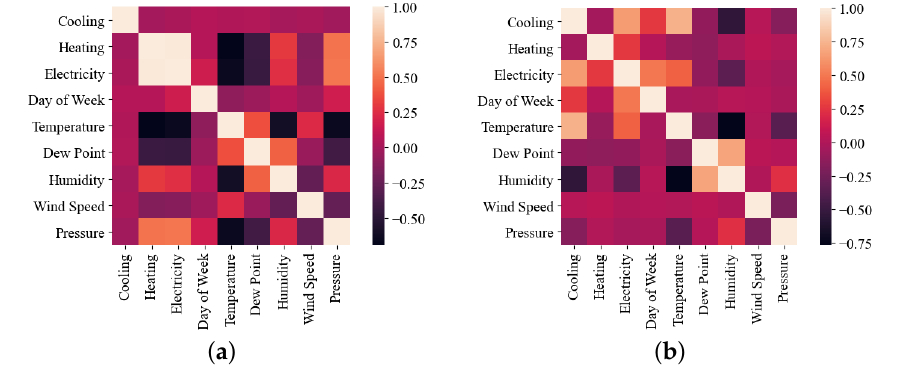
Figure 3. Characteristics correlation analysis heat map. ( a ) The heating season, which is from January to May and from October to December. ( b ) The non-heating season, which is from June to September. In Figure 3, the legend represents the correlation degree between attributes, and the coefficients take values in the range of [ − 1, 1]. When the coefficient is 0, it means that the two attributes are not correlated at all; when the coefficient is positive, it means that the attributes are positively correlated with each other; and when the coefficient is negative, they are negatively correlated. In Figure 3a, the coefficient of the electricity load and cooling load is 0.0236; the coefficient of the electricity load and heating load is 0.9828; and the coefficient of the heating load and cooling load is −